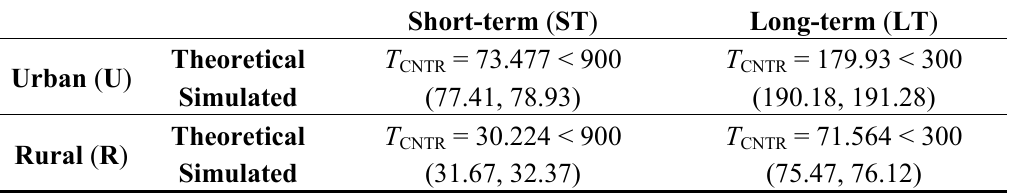
Table 13. Summary of Backhaul network results (Transmission Time in